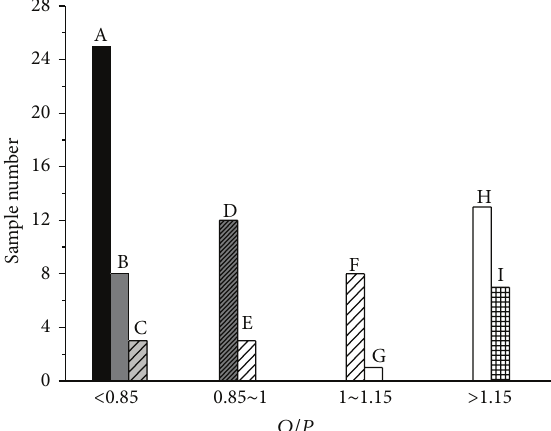
Figure 12: Histogram for piles with different defect classifications.